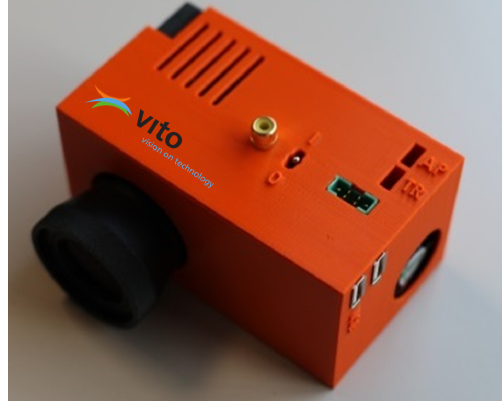
Figure 1. Compact hyperspectral imaging